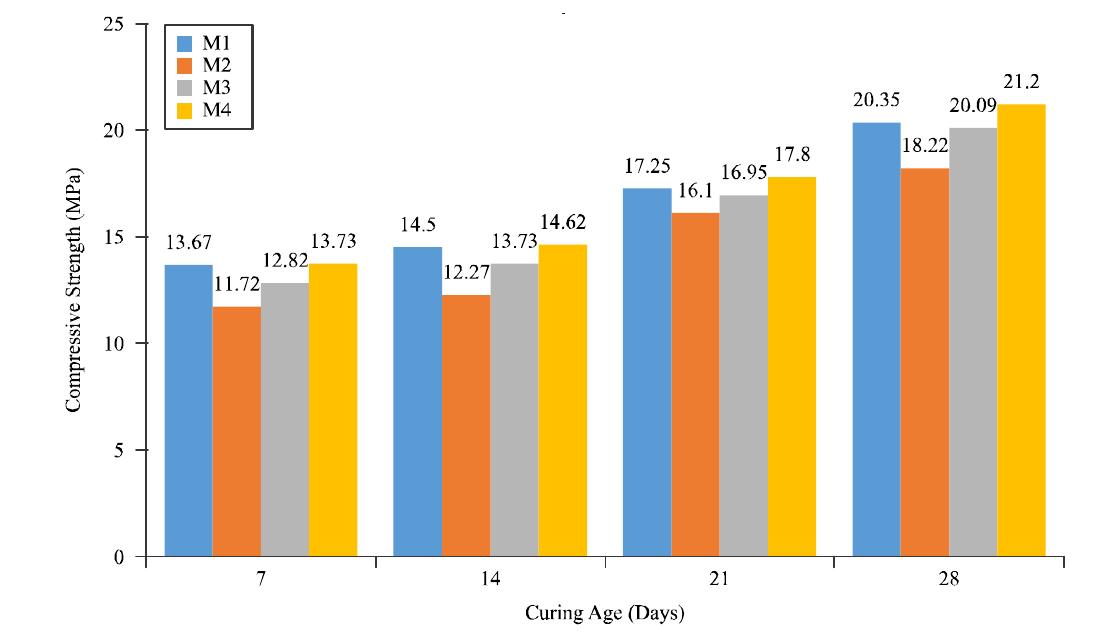
FIG. 12. COMPARISON OF COMPRESSIVE STRENGTH AT DIFFERENT AGES OF ALL